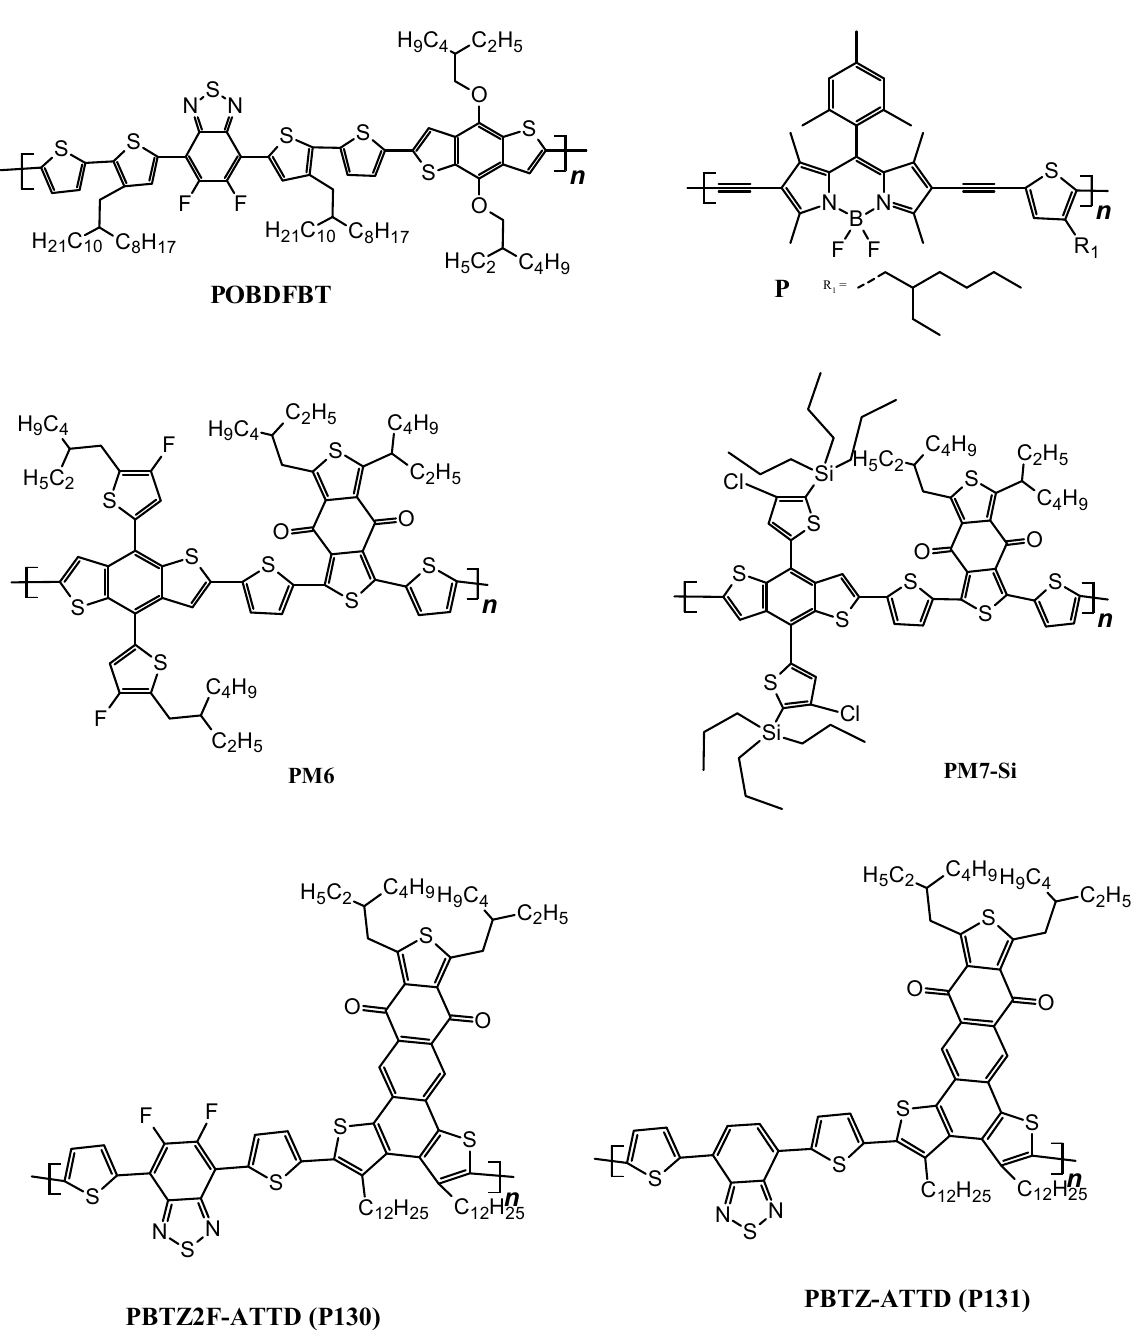
Figure 4. Chemical structures of medium bandgap polymers used in BHJ solar cells. Chen et al. described the enhanced photovoltaic performance by using a novel me- dium bandgap polymer as the donor for BHJ. A copolymer based on thiophene, diflurobenzothiadiazole (FBT) and benzodithiophene (BDT) motifs were synthesized and